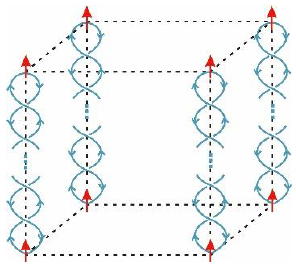
Figure 3. A unit cell of the 3D cubic Ising lattice (black dashed lines) with spins (red arrows) located at every lattice site and braids (blue curves) attached to every pair of the two nearest neighboring lattice sites along the third dimension. The spins represent the linear terms in the transfer matrices, while the braids represent the nontrivial knots, namely, the nonlinear terms of Γ -matrices of the transfer matrices, of the 3D Ising lattice.